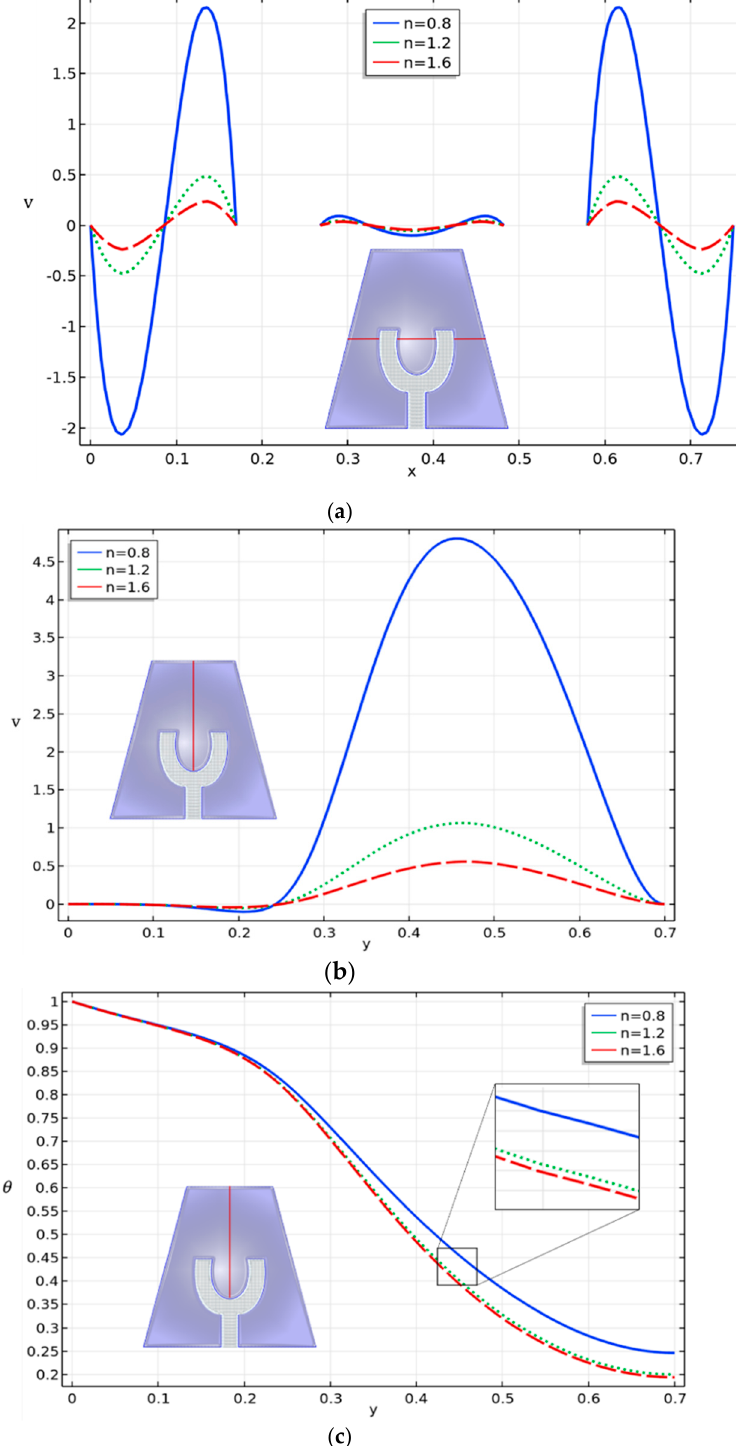
Figure 9. ( a ) Cutlines for 𝑣 component of velocity for different values of power law index (𝑛) at 𝑦 = 0.5 . ( b ) Cutlines for v component of velocity for different values of power law index (n) at x = 0.5. ( c ) Cutlines for temperature distribution 𝜃 for different values of power law index (𝑛) at 𝑥 = 0.5 . Figure 9b describes the variation in the horizontal component of the velocity w.r.t varying 𝑦 . It is clear from the illustration that initially the velocity of the liquid at zero